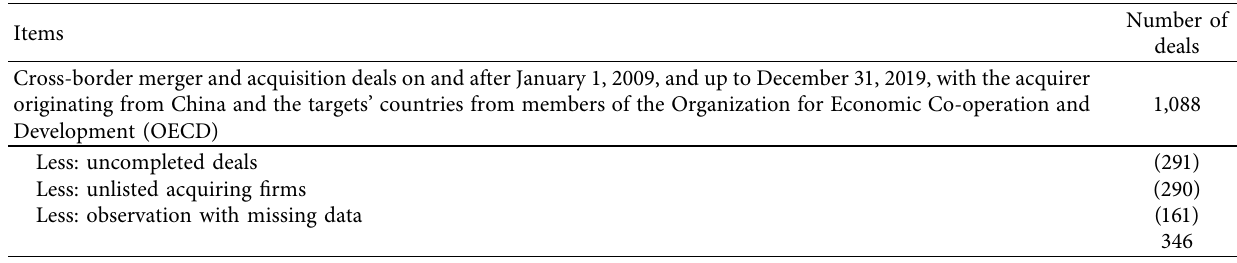
Table 4: Sample for estimating the bidder’s profit.